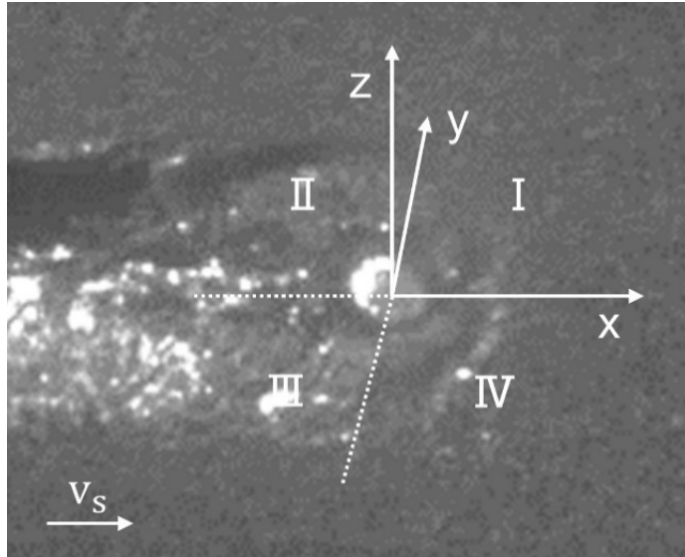
J. Manuf. Mater. Process. 2019 , 3 , 71 Figure 4. Classification into quadrants at keyhole outlet region. Figure 4. Classification into quadrants at keyhole outlet region.